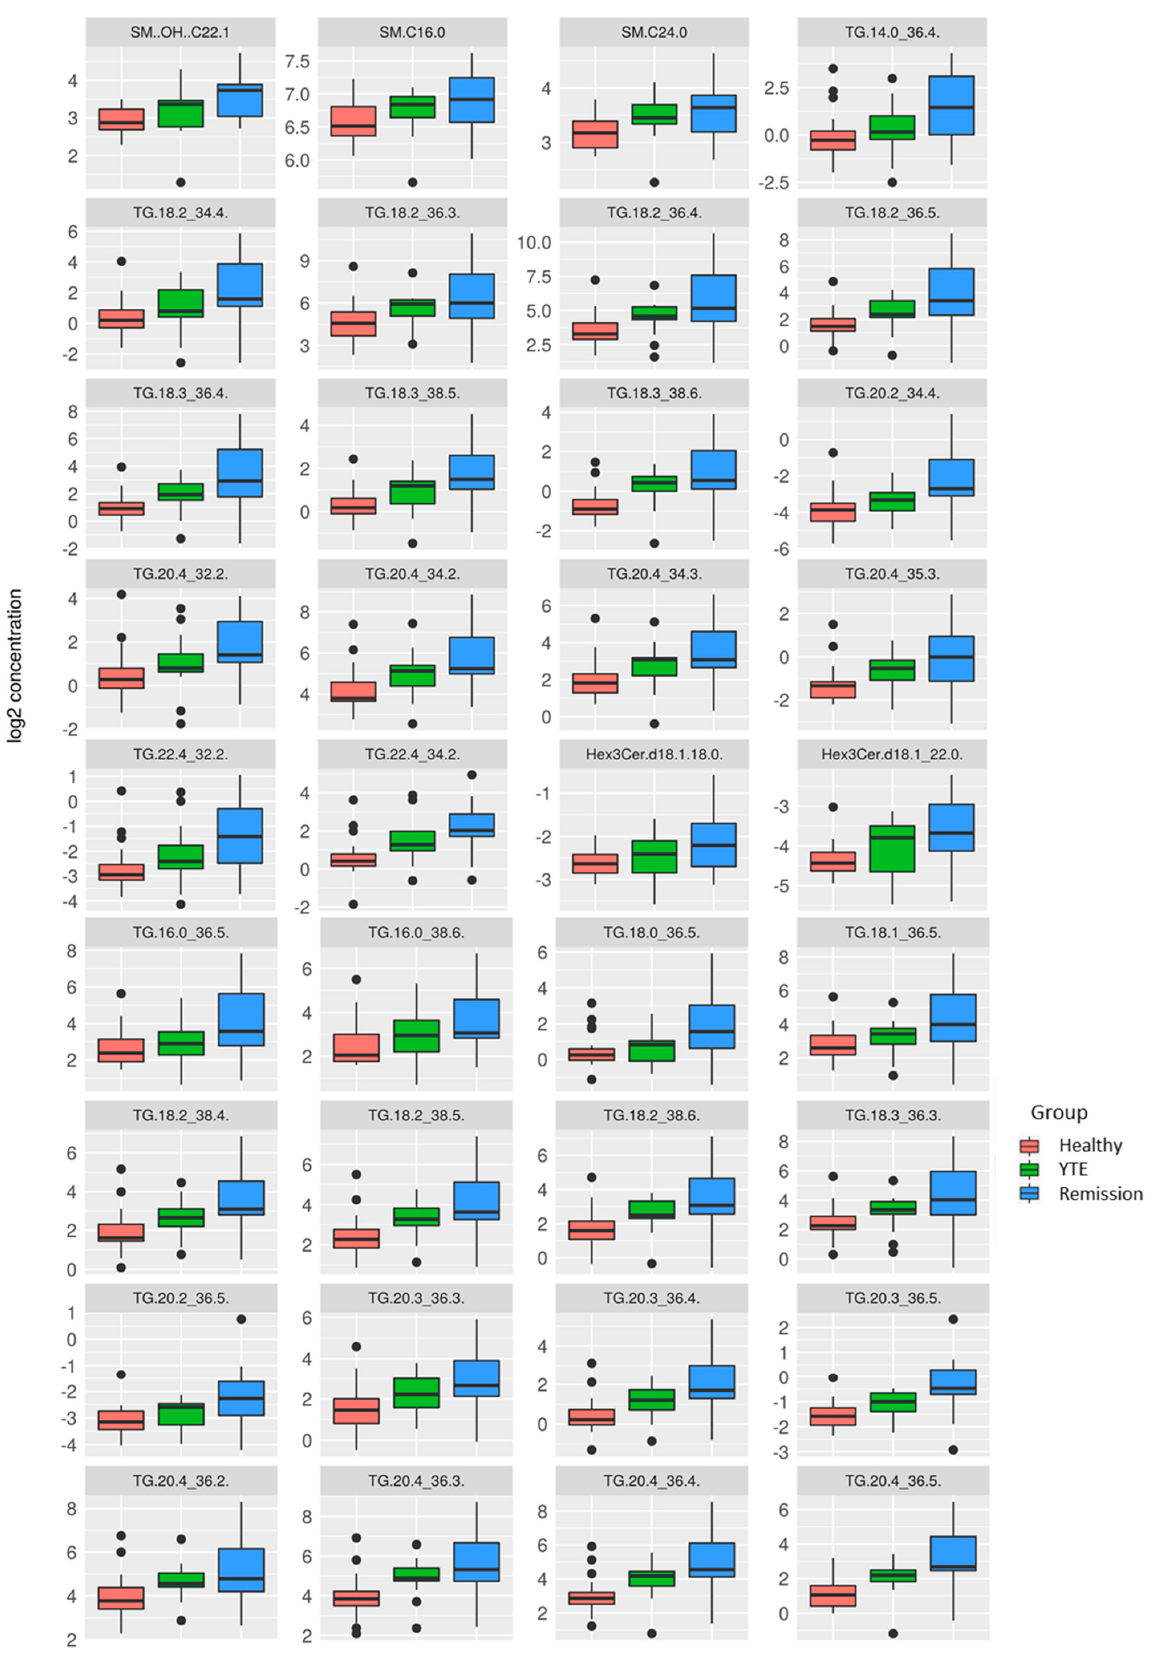
Figure 6. Box plots comparing metabolites after log-2 transformation in healthy controls, dogs